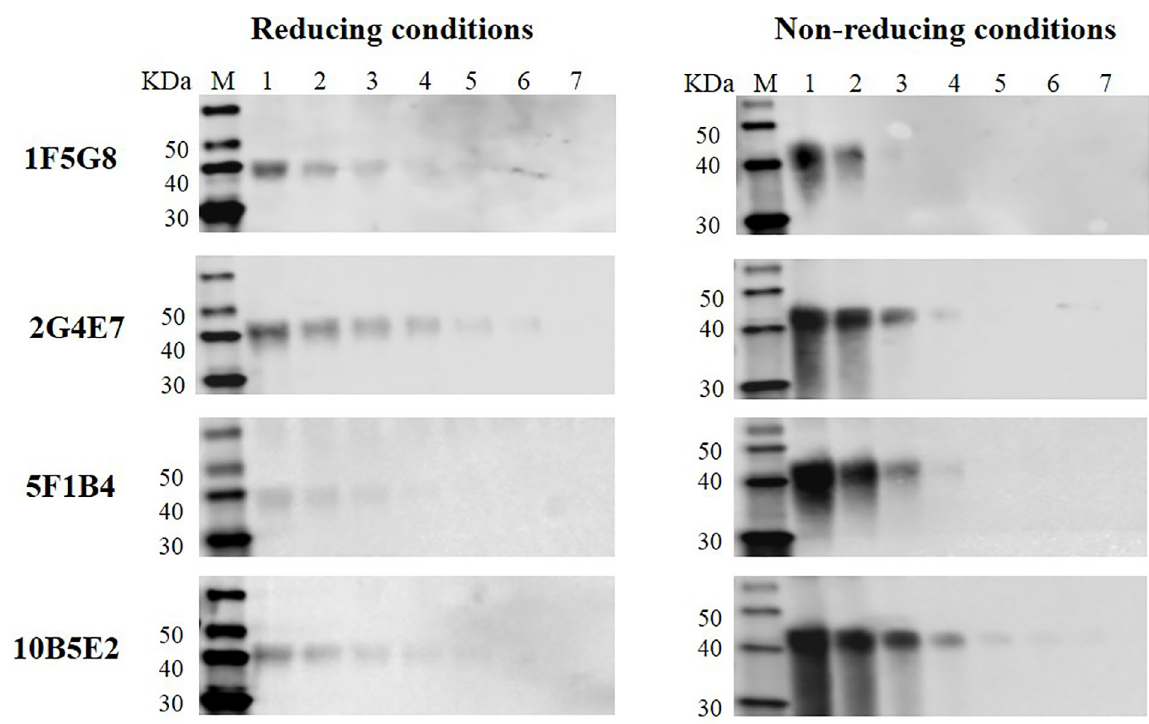
Fig 2. Identification of the purified ILTV gG recombinant protein by monoclonal antibodies (1F5G8, 2G4E7, 10B5E2, and 5F1B4) under reducing and non-reducing conditions in western blot. Lane M: Molecular weight marker (kDa). Two-fold serial dilution of the purified protein: lane 1: 1000 ng; lane 2: 500 ng; lane 3: 250 ng; lane 4: 125 ng; lane 5: 62.5 ng; lane 6: 31.25 ng; lane 7: 15.6